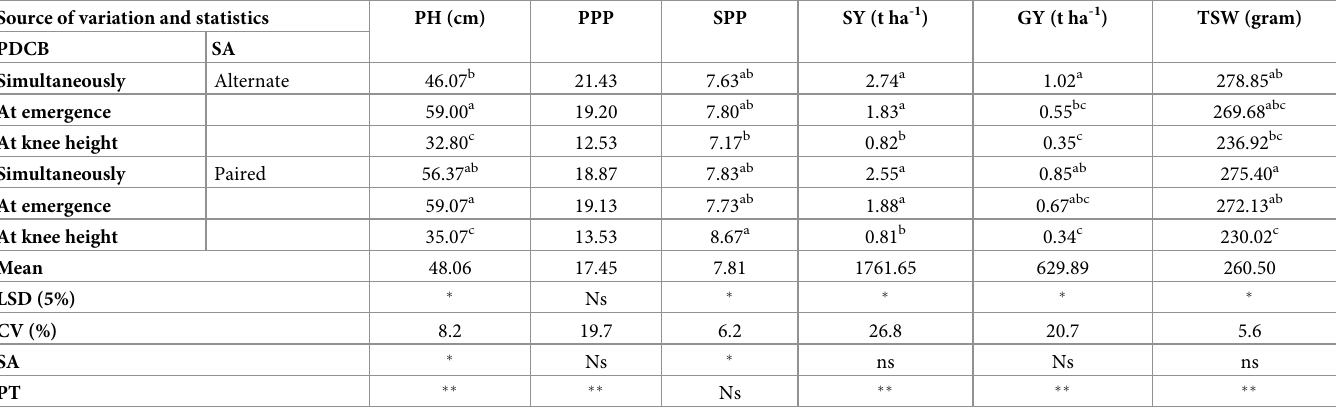
Table 4. Response of common bean yield attribute and yield to its planting time and spatial arrangement in maize -common bean intercrops at Finoteselam sub- research station, Northwestern Ethiopia a . Source of variation and